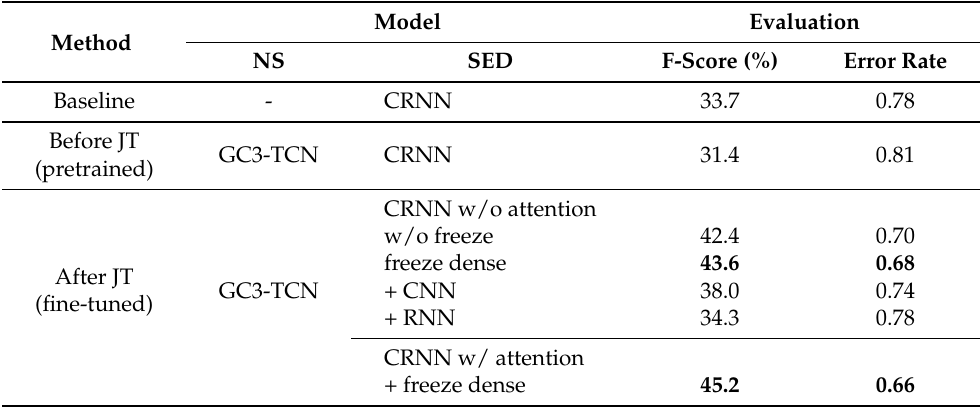
Table 3. Performance comparison using the simulated noise dataset for input mixture. JT denotes joint